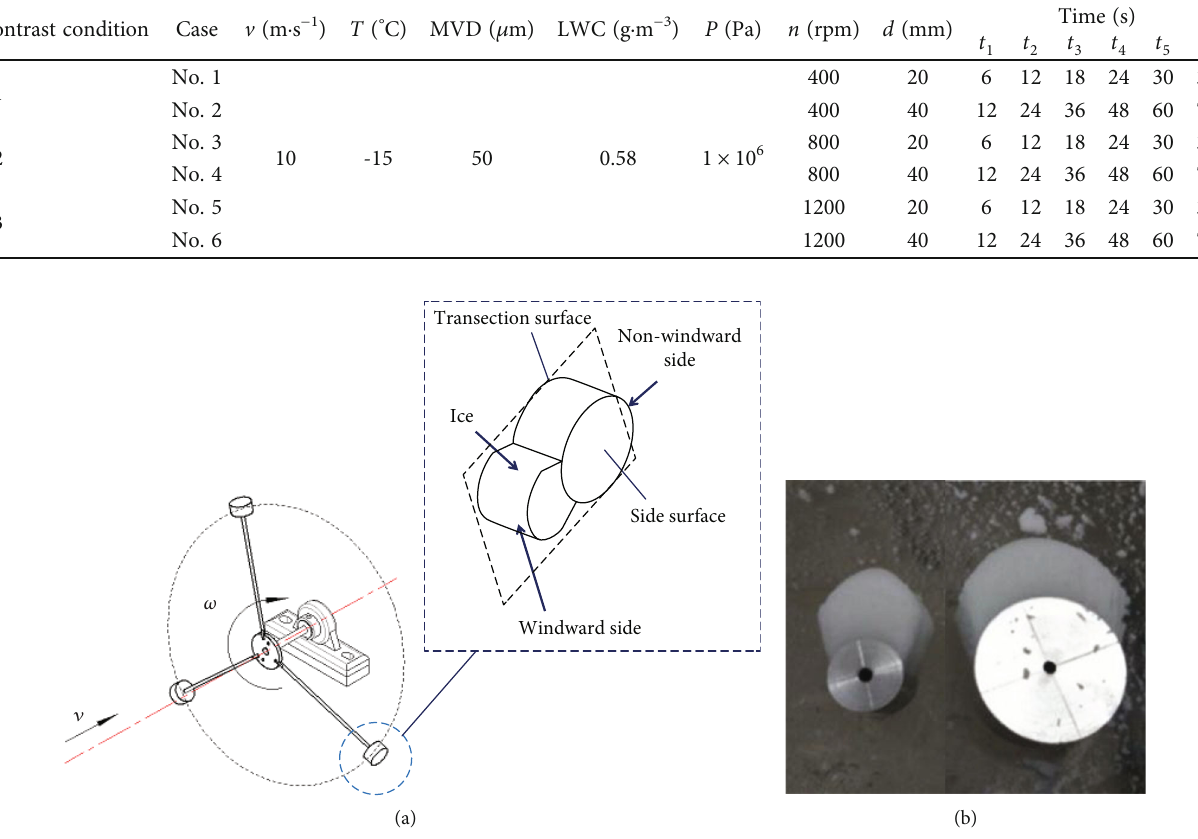
Figure 7: Icing distributions on surfaces of rotating cylinders: (a) schematic diagram of the rotating cylinder; (b) distributions of icing on the